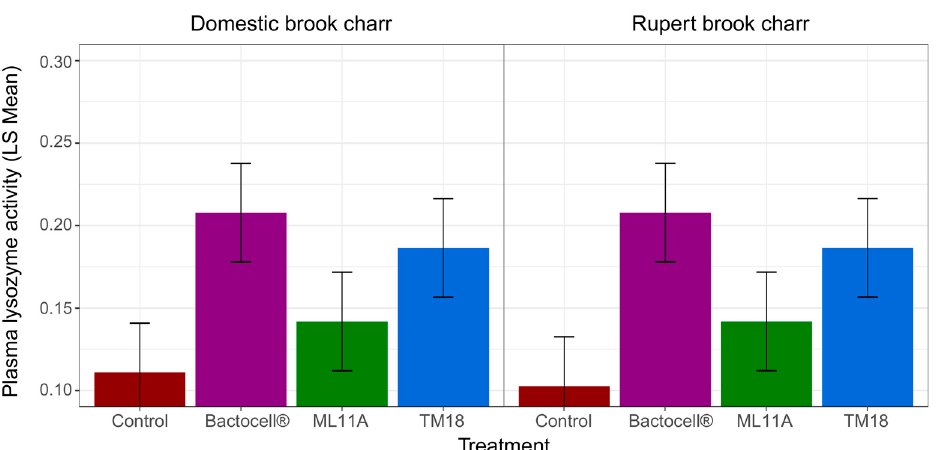
Figure 7. Blood plasma lysozyme activity, measured at 120 days of probiotic treatment exposure. One unit (U) is defined as a decrease of 1 A 600 unit per minute per mL of M. lysodeikticus mixed with 6.6% fish blood serum. Bars are least-square (LS) mean estimates, and horizontal lines represent the 95% confidence interval for each mean estimate. Control: no probiotic treatment. Table 6. Kruskal-Wallis rank sum test of blood plasma lysozyme activity, with either Treatment or Lineage as explanatory variables.